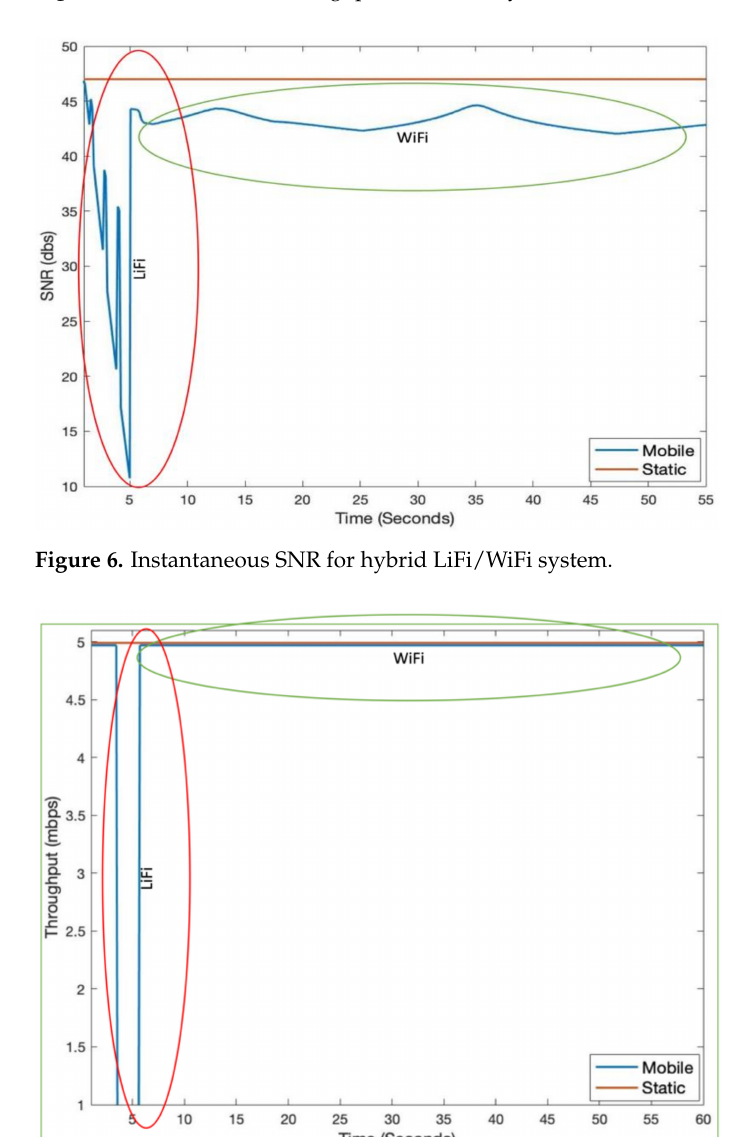
Figure 5. Instantaneous throughput for LiFi-only mobile user.